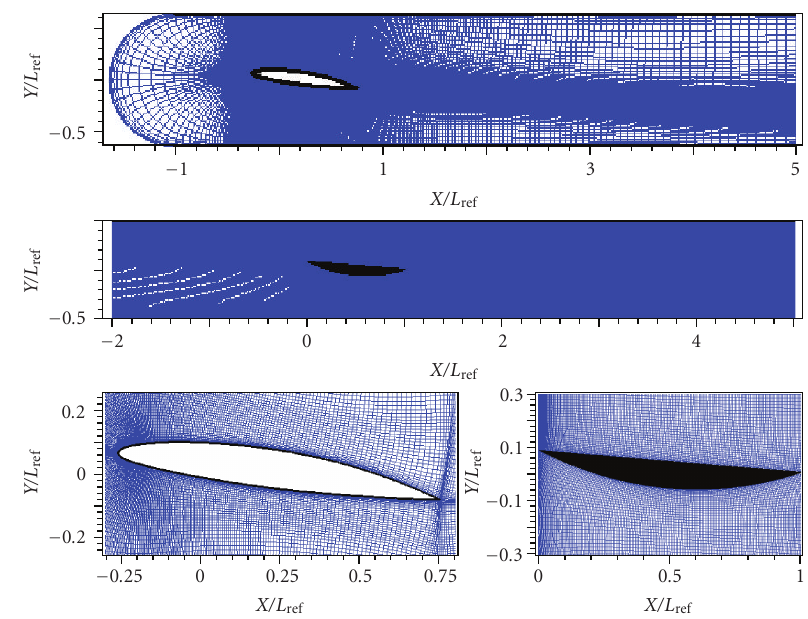
Figure 3: General view of the grid, flow is from the left.